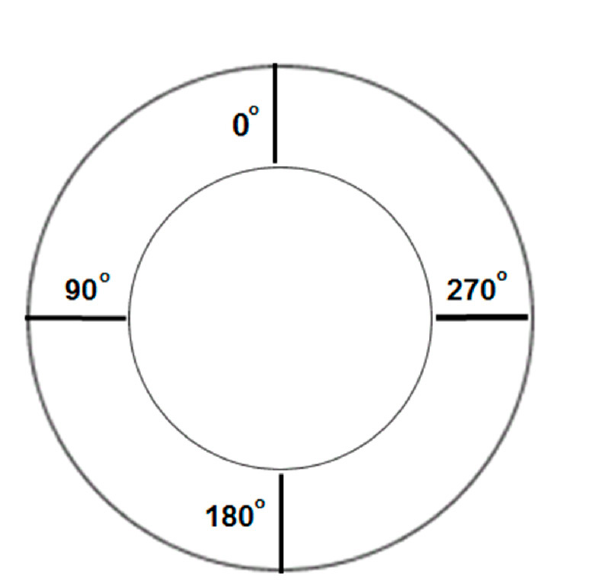
Figure 1. Schematic representation of a cross section of the aorta showing the locations where measurements of the wall thickness were taken.